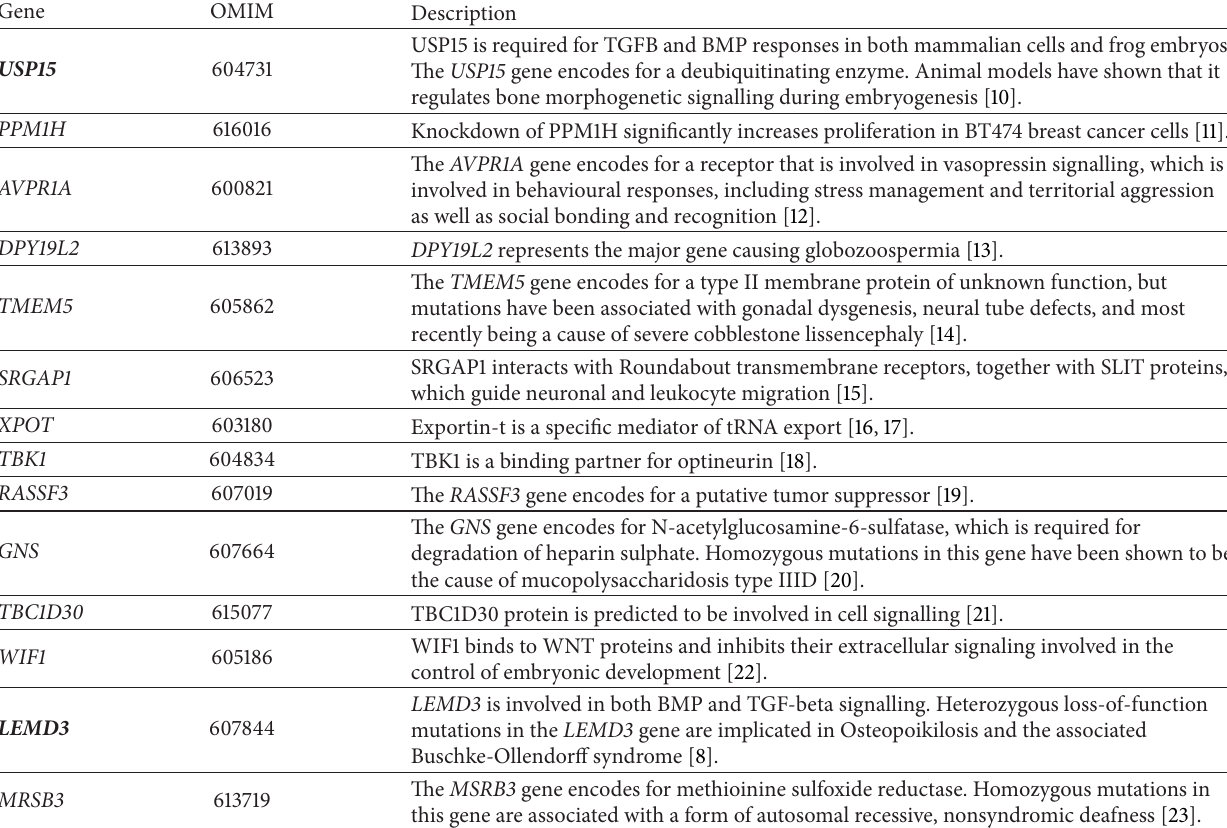
Table 2: OMIM genes that lie in the 12q14 interval bounded by USP15 and MSRB3